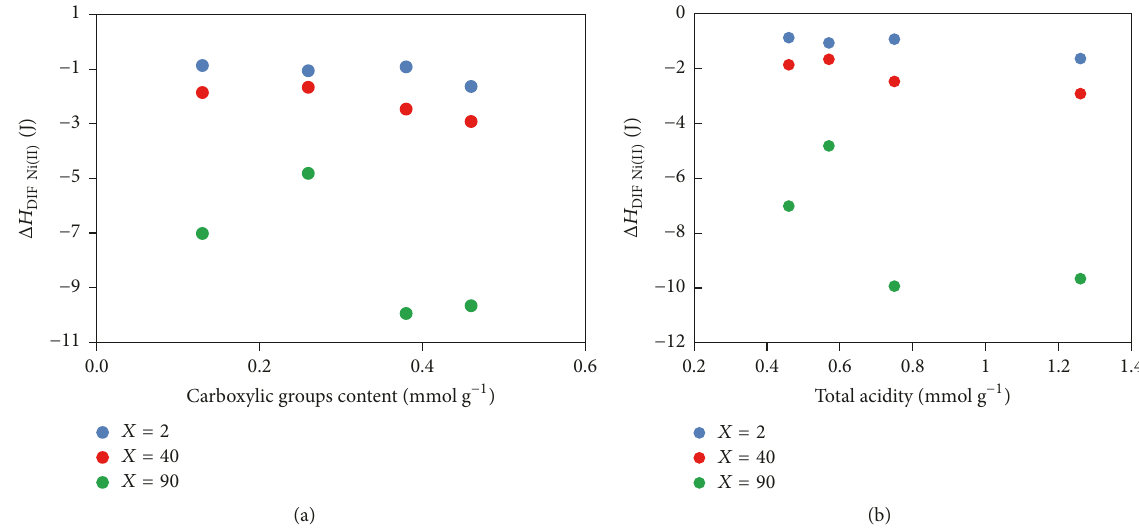
, in function of the oxygen content groups on the carbonized surface. (a) Ni ( II )